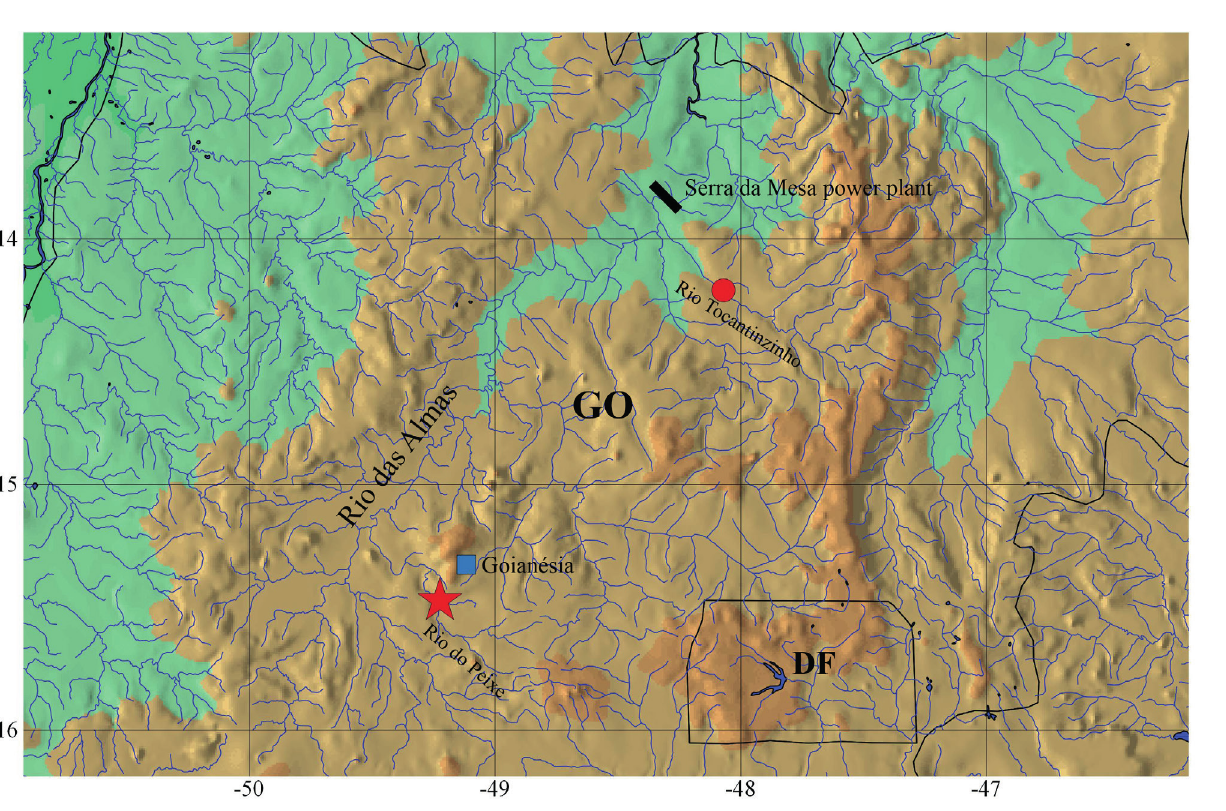
FIGURE 6 | Map of Rhyacoglanis varii distribution through upper rio Tocantins basin (red dot = rio Tocantinzinho tributary; red star = type locality, rio do Peixe), state of Goiás (GO), Brazil. DF = Federal District of